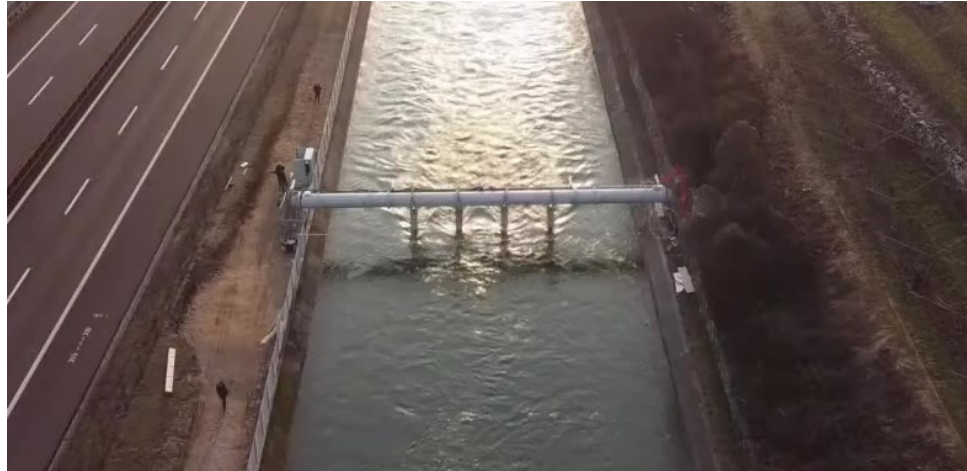
Figure 1. An array of aligned vertical-axis cross-flow hydrokinetic turbines deployed in a regular canal. Image from HE Powergreen S.r.l. [3].